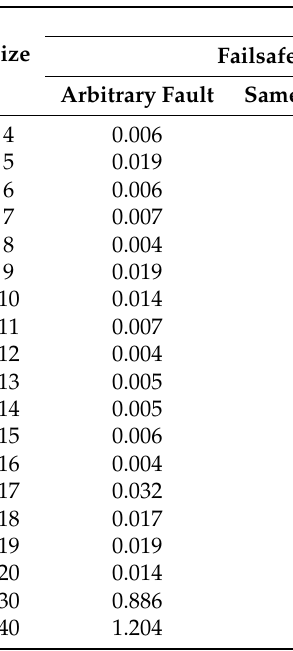
Table 2. Average Time of Addition of Fault-tolerance for Shepherding